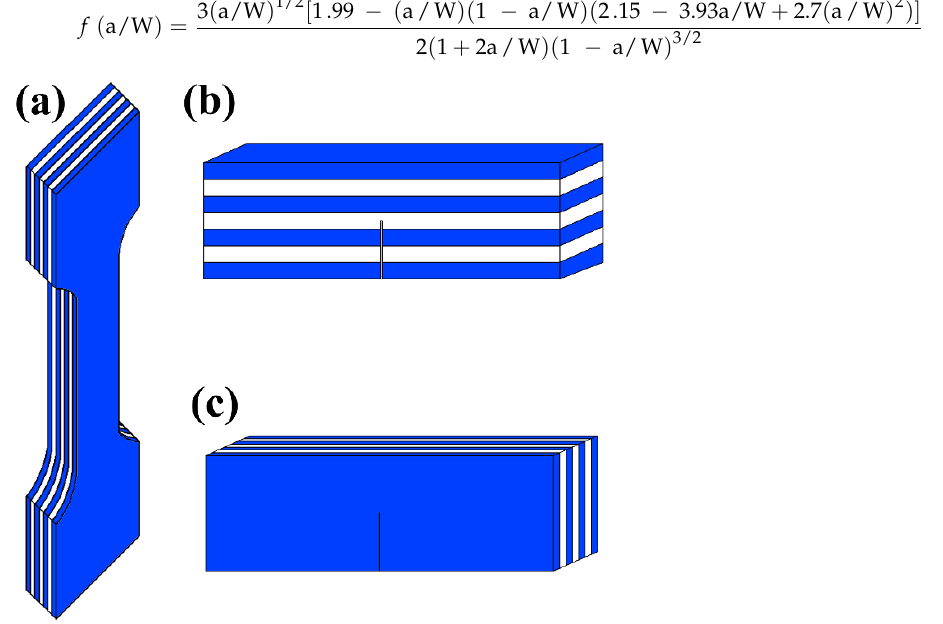
Figure 1. ( a ) Schematic diagram of tensile samples and fracture toughness samples in ( b ) arrester orientation and ( c ) divider orientation, respectively (Deep blue regions represent the TiAl alloy and white regions represent the DsTi700 alloy).